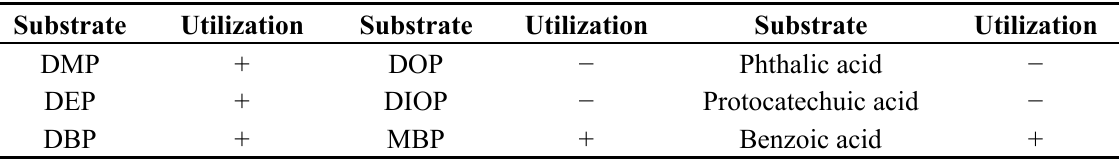
Table 1. Substrate utilization profile for strain